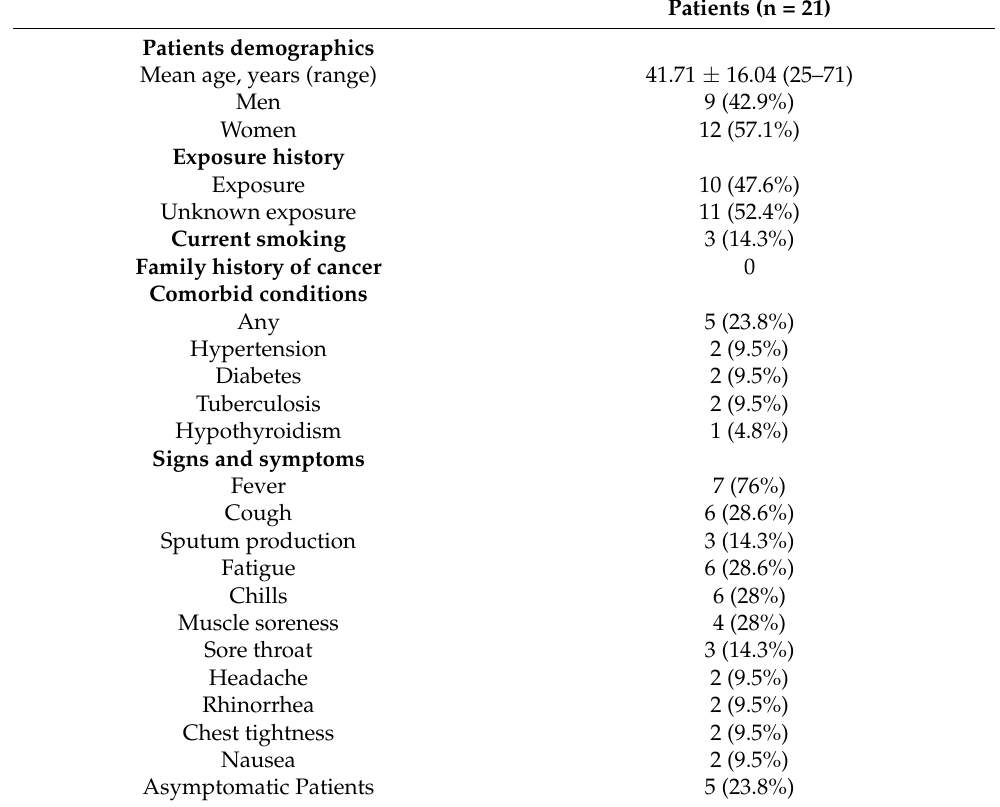
Table 4. Patient characteristics of COVID-19 patients with SPN.